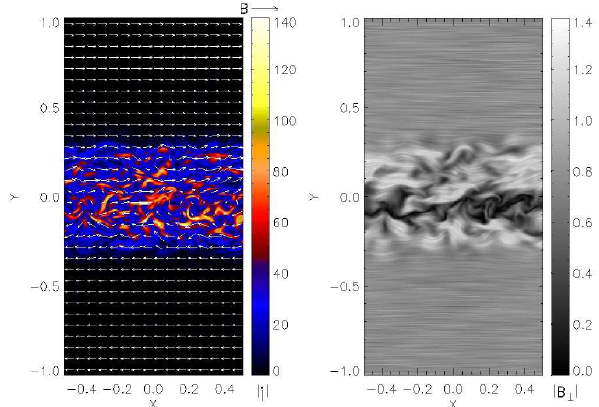
Fig. 2. Left panel: current intensity and magnetic field configura- Fig. 2. Left panel : Current intensity and magnetic field configuration during stochastic reconnection. We show tion during stochastic reconnection. We show a slice through the a slice through the middle of the computational box in the xy plane after twelve dynamical times for a typical middle of the computational box in the xy plane after twelve dy- namical times for a typical run. The shared component of the field run. The shared component of the field is perpendicular to the page. The intensity and direction of the magnetic is perpendicular to the page. The intensity and direction of the mag- field is represented by the length and direction of the arrows. The color bar gives the intensity of the current. netic field is represented by the length and direction of the arrows. The reversal in B x is confined to the vicinity of y=0 but the current sheet is strongly disordered with features The color bar gives the intensity of the current. The reversal in B x is confined to the vicinity of y = 0 but the current sheet is strongly that extend far from the zone of reversal. Right panel : Representation of the magnetic field in the reconnection disordered with features that extend far from the zone of reversal. zone with textures. Right panel: representation of the magnetic field in the reconnection zone with